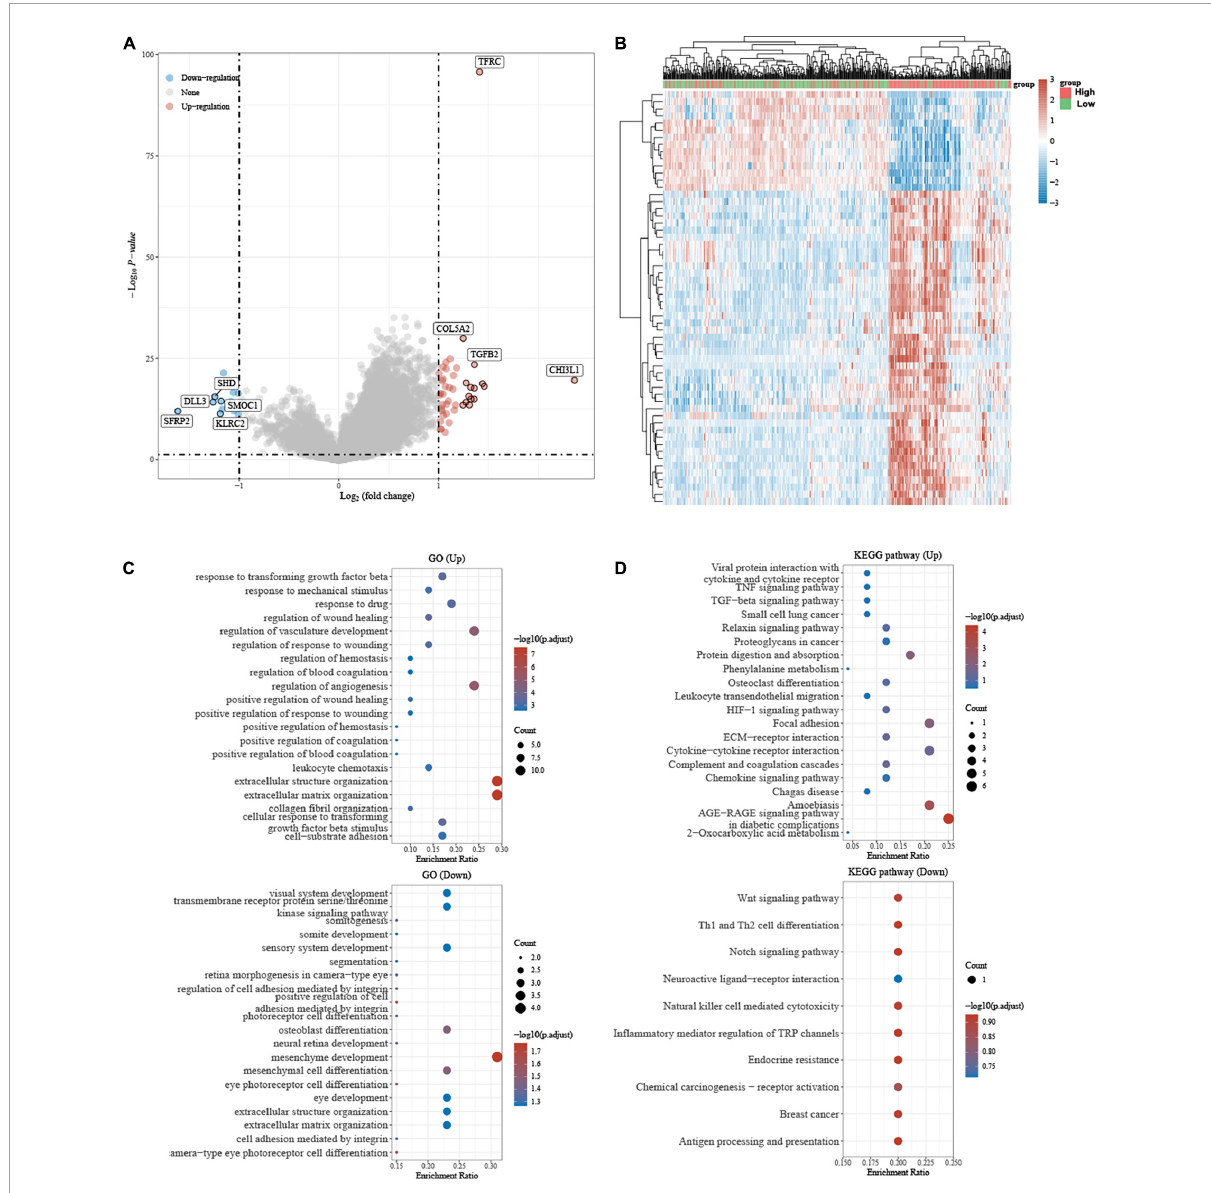
FIGURE7 The differential gene expression and Gene ontology (GO), Kyoto Encyclopedia of Genes and Genomes (KEGG) Enrichment Analysis. (A) Volcano plot, red dots: upregulated genes; blue dots: downregulated genes. (B) Heat map: Different colors represent gene expression trends in different tissues. (C,D) GO and KEGG analysis showed that the biological functional enrichment, the circle’s size represents how many genes are differentially enriched, and the color represents its